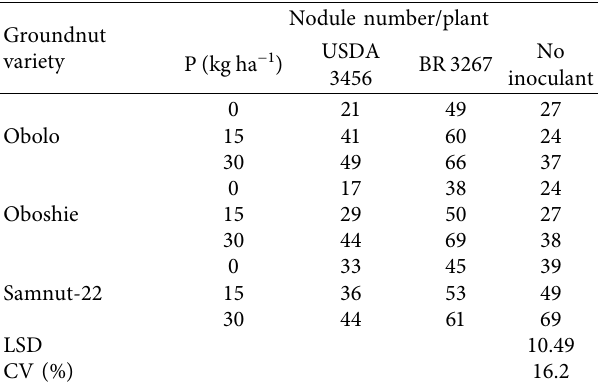
Table 3: Interaction effect of rhizobium and P fertilizer on nod- ulation of three groundnut